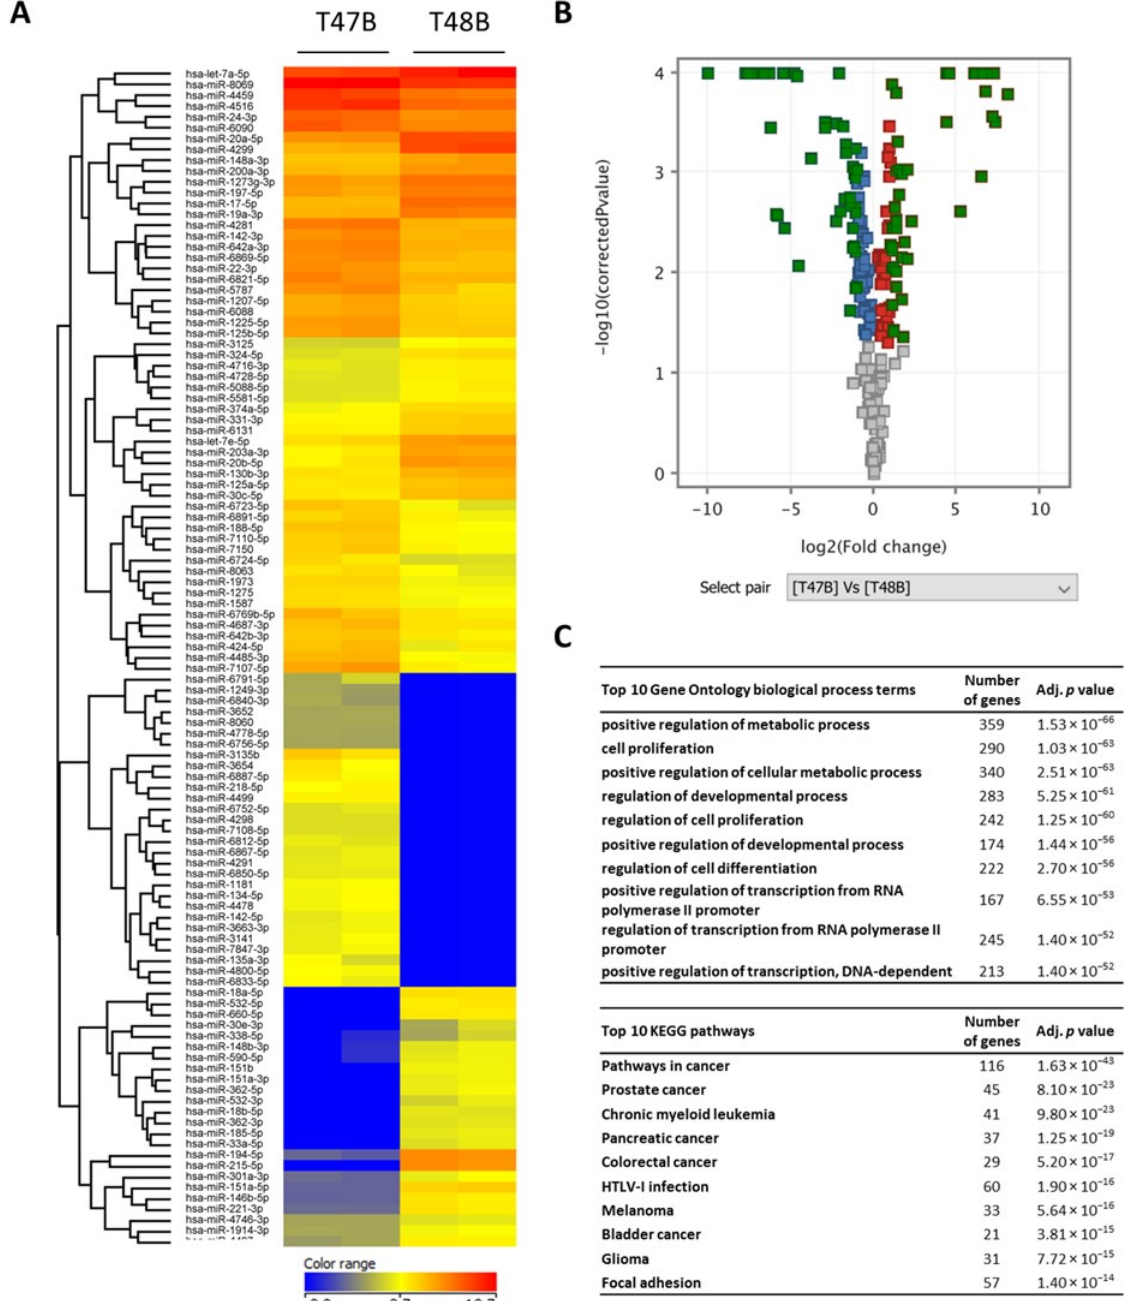
Figure 6. Heatmap with the unsupervised hierarchical clustering of differentially expressed miR- NAs between mice-implanted cells of 47B and 48B colon cancer primocultures (( A) , volcano plot of miRNA array results (differentially expressed miRNAs are green colored) ( B ), and top 10 significant Gene Ontology (GO) biological process terms and KEGG pathways ( C ).